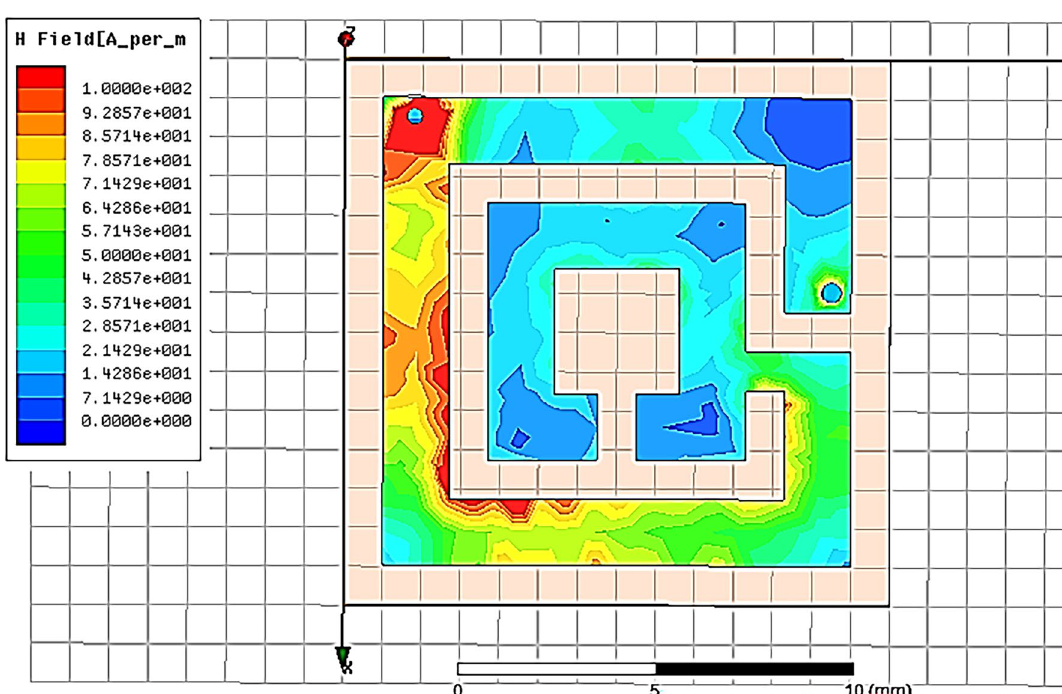
Figure 4. Current distribution of the proposed antenna at MICS